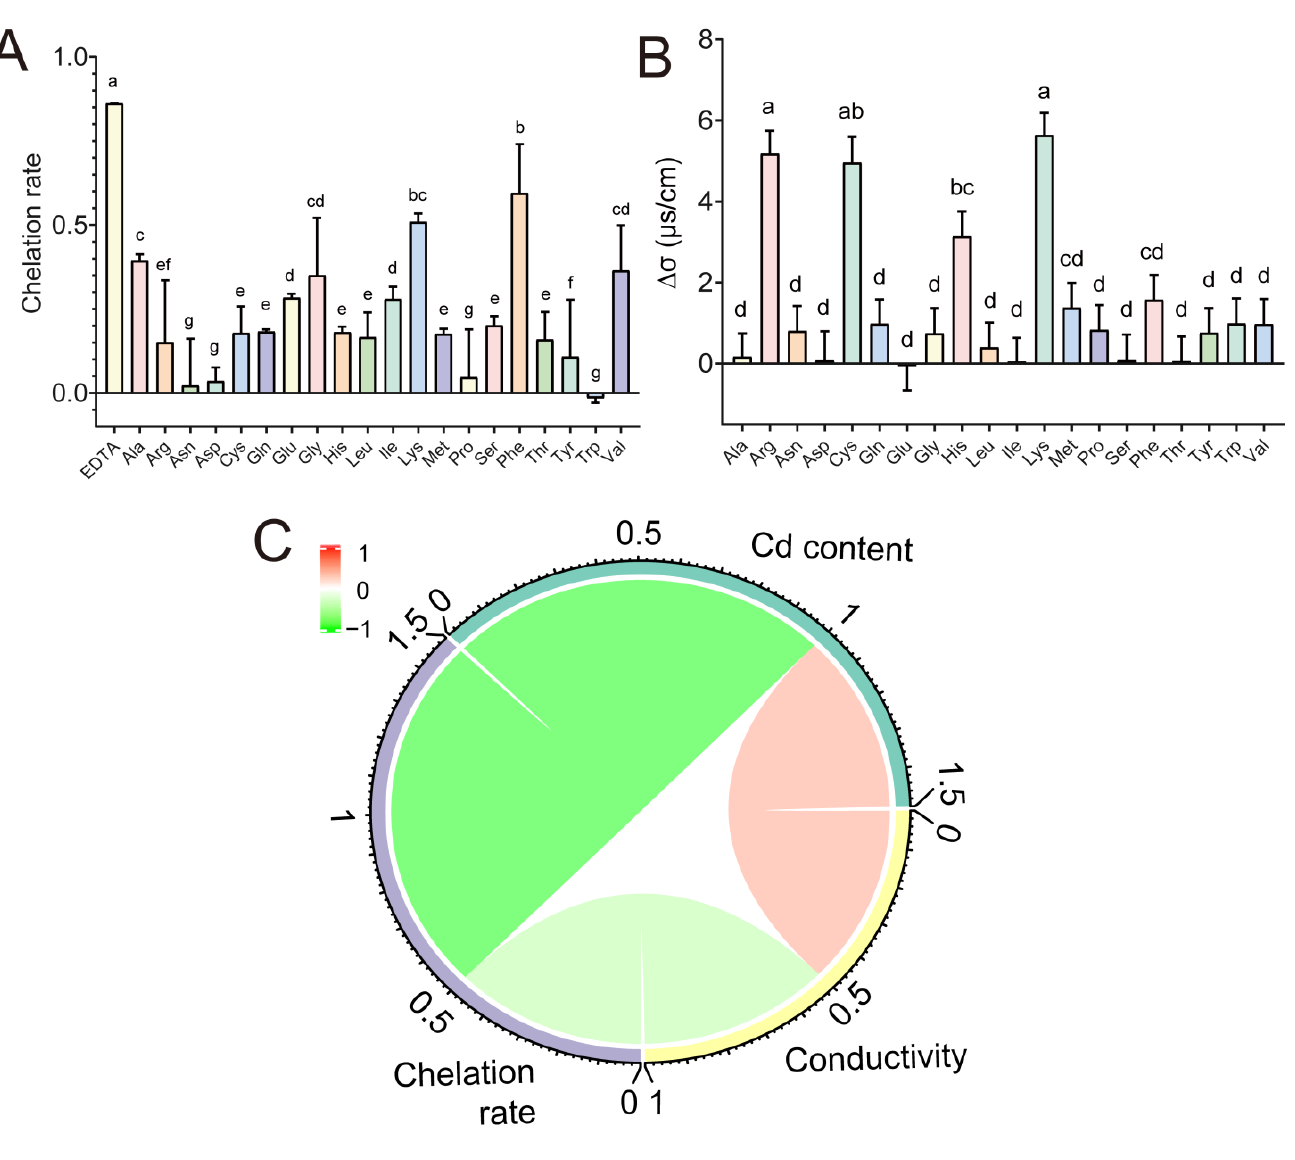
Figure 2. Determination of the Cd chelating ability of 20 AAs. ( A ) CAS assay for Cd chelating features of 20 AAs. ( B ) Changes in conductivity are caused by metal chelating ability. ( C ) Spearman’s correlations among content, conductivity, and chelation rate. Different superscript letters indicate significantly different at p < 0.05 among AAs-treated groups.